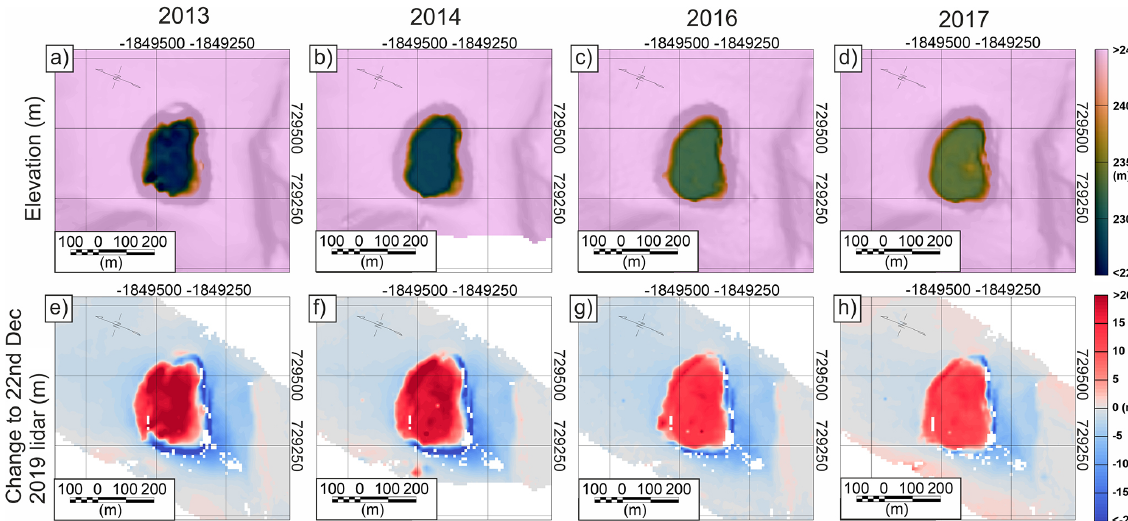
Figure 5. Long-term surface elevation changes from REMA strip DEMs over the PICS. Panels (a) – (d) show REMA DEMs from 2013 to 2017, corrected to the area of reference elevation shown in Fig. 3a. Note uniform colour scale, clipped to accentuate variations in the elevation of the PICS floor. Panels (e) – (h) show elevation difference between strip DEMs and 22 December lidar elevation grid – positive values show areas where elevation has increased with time as the cavity has refilled, and negative values show areas of the catchment where elevation has decreased as a (likely) result of surface melt. Note deep and more rugged floor of the PICS in 2013 which suggests either that drainage may have been complete, allowing the basal topography to show through, or more likely that the raised features are fragments of a collapsed ice cliff or ice blisters (Moore, 1993). The very flat base of the PICS in subsequent years would be consistent with progressive filling of the cavity and floatation of ice off the bed or the melting or incorporation of these features.